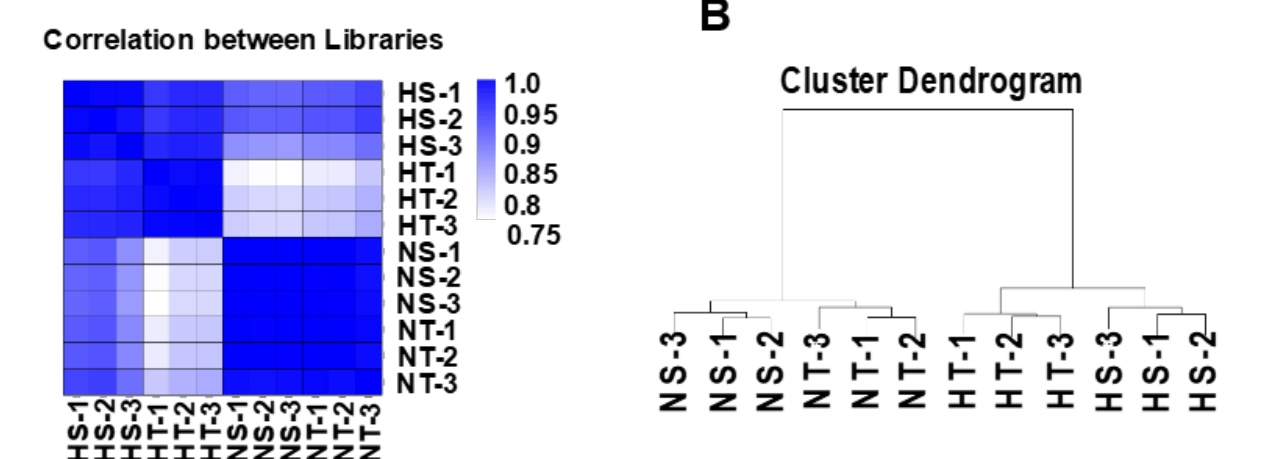
Figure 6. Summary of gene expression of each sample: ( A ) Pearson correlations between all samples; and ( B ) Hierarchical clustering between all samples. NT, normal growth condition under 25/18 °C and water; NS, normal growth condition under 25/18 °C with 1 mM Spd treatment on plants; HT, high temperature growth condition on 38/28 °C and water treatment; HS, high temperature growth condition on 38/28 °C with 1 mM Spd treatment on leaves.